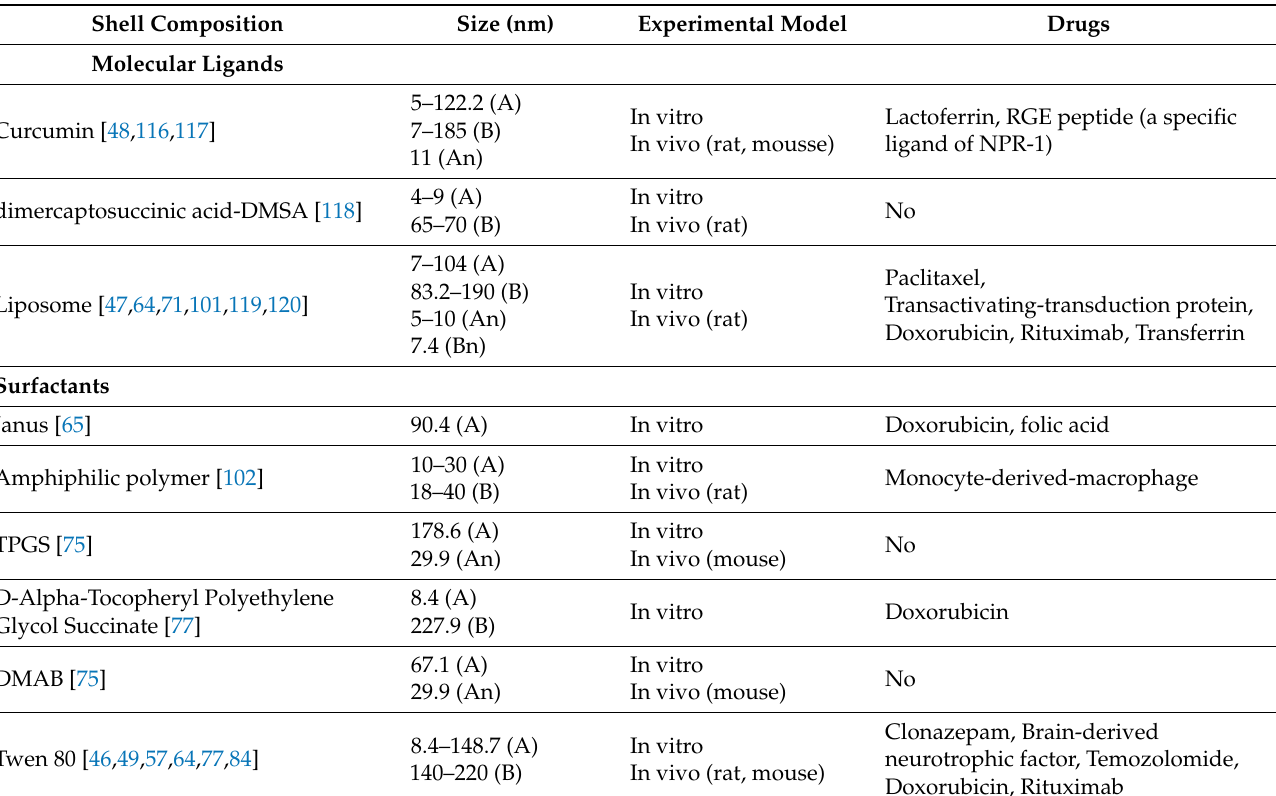
Table 3. Miscellaneous SPIONs shells A: core size with shell (Transmission Electron Microscopy), B: hydrodynamic size with shell (Dynamic Light Scattering), An: naked core size, Bn: naked hydrodynamic size. Shell